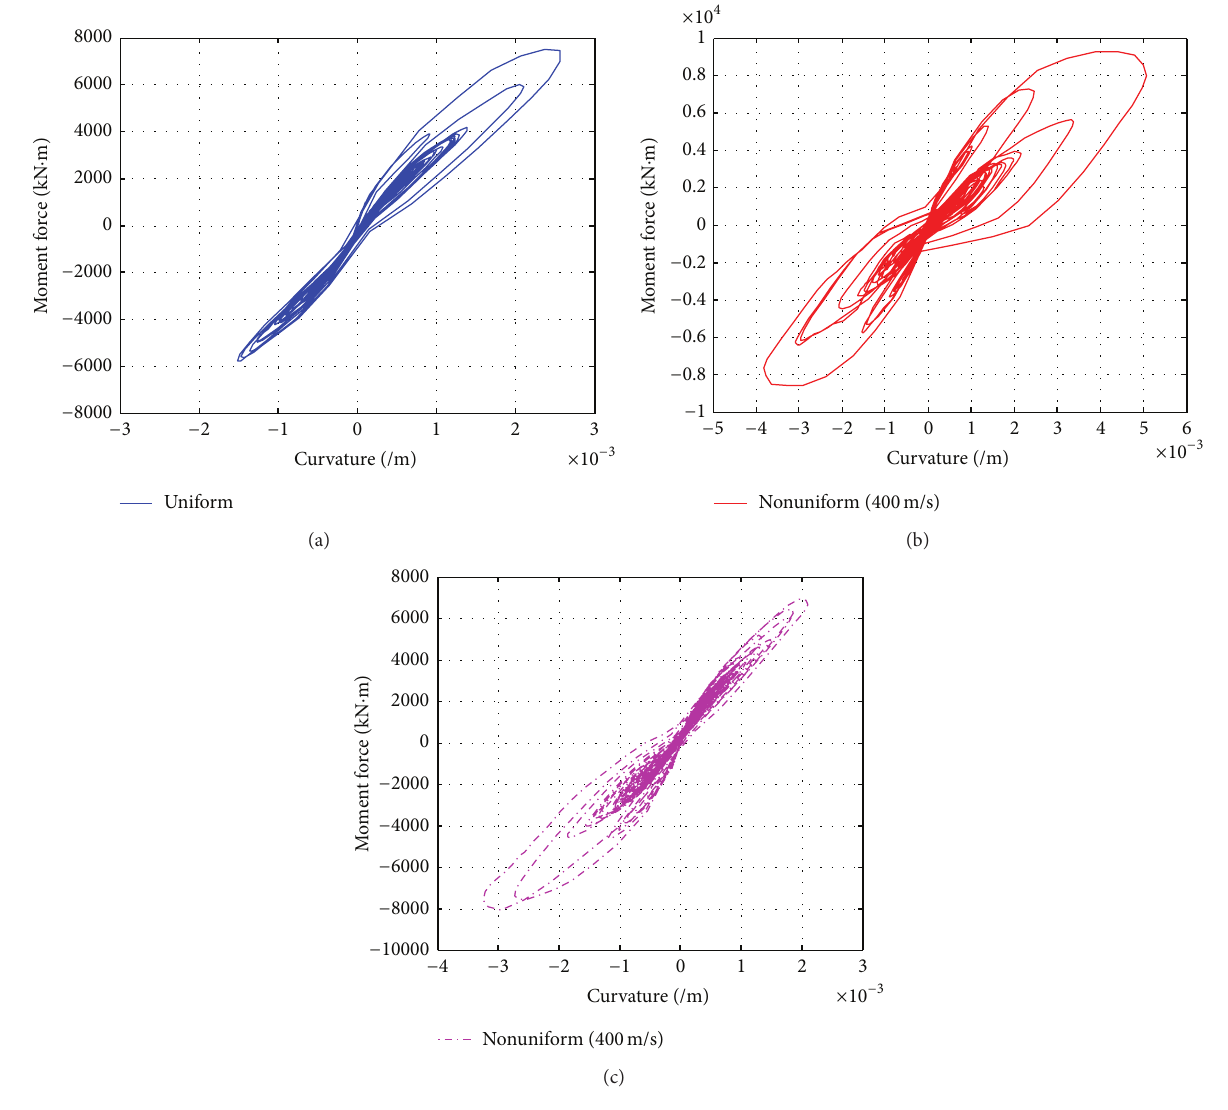
Figure 12: Moment versus curvature relationship of piers.